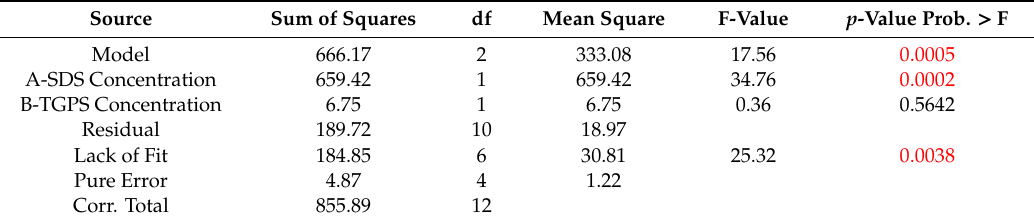
Table 6. ANOVA data for response surface linear model for